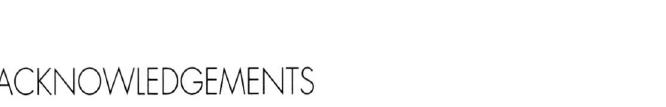
tion, treated mice were dosed intraperitonealy once a day with 10 mg kg of body weight with furan-2-car- boxamide and the controls received 0.9 % saline solu­ tion, both for five consecutive days. Twenty